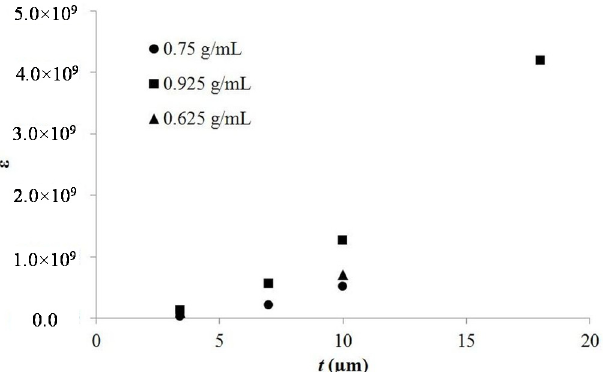
Figure 3. Dielectric constant as a function of thickness. This plot clearly demonstrates that unlike other materials that have a single dielectric constant, the TSDM “material” is defined by tube length. Indeed, it is clear that the dielectric constant is not a linear function of length, but proportional to length squared. Finally, note each TSDM with different tube length is effectively a unique material with a unique dielectric